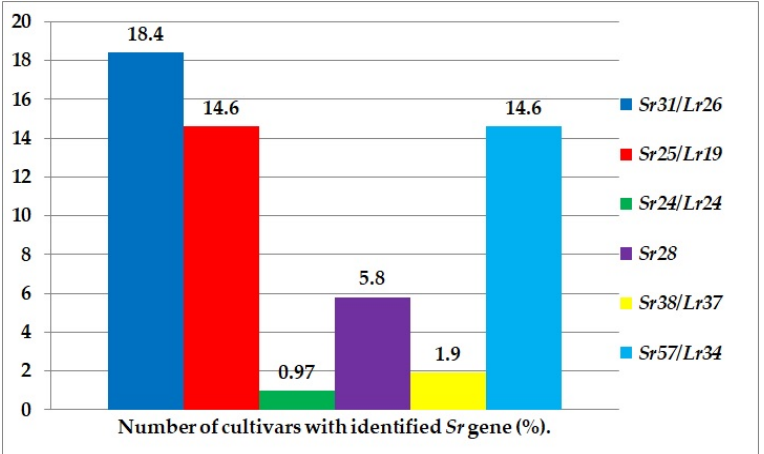
Figure 3. Representation of Sr genes in the studied wheat cultivars. Sr31 ( ’100 let TASSR’, ‘Balkysh’, ‘Chistopol’skaya’, ‘Ekada 253’, ‘Ekada 258’, ‘Ekada 265’, ‘Ershovskaya 36’, ‘Kur’er’, ‘Kvartet L 375’, ‘Prohorovka’, ‘Yugo-Vostochnaya 2’, ‘Yugo-Vostochnaya 4’, Antonina’, ‘Bezostaya 100’, ‘Bul- gun’, ‘Gurt’, ‘Svarog’, ‘Timiryazevka 150’, and ‘Vekha’); Sr25 (‘Aleksandrit’, ‘Dobrynya’, ‘Ekada 113’, ‘Hazine’, ‘Kinel’skaya 2010’, ‘Kinel’skaya niva’, ‘Kinel’skaya yubilejnaya’, ‘Kvartet L 375’, ‘L 503’, ‘L 505’, ‘Lebedushka’ ‘Tulaikovskaya 10’, ‘Tulaikovskaya 108’, ‘Tulaikovskaya nadezhda’, and ‘Ul’yanovskaya 105’); Sr24 (‘Ekada 265’); Sr28 (‘Chistopol’skaya’, ‘Kur’er’, ‘Margarita’, ‘Sakara’, ‘Yugo-Vostochnaya 4’, and ‘Vertikal’); Sr38/Lr37 (’Graf’ and ‘Svarog’); and Sr57/Lr34 (‘Bair’, ‘Bazis’, ‘Chernozemka 115’, ‘Hasyr’, ‘Liga 1’, ‘Malahit’, ‘Proton’, ‘Resurs’, ‘Skirda’, ‘Svetoch’, ‘V’yuga’, ‘Chistopol’skaya’, ‘Ekada 253’, ‘Kazanskaya Yubilejnaya’, and ‘Zhigulevskaya). Despite the fact that wheat cultivars with the Sr31 gene are affected by the Ug99 race and its biotypes, Sr31 remains the only gene present in Russian commercial cultivars that is effective against all Russian populations of the stem rust pathogen [4,27,28]. However, there were alarming reports about P. graminis f. sp. tritici isolates from the West Siberian stem rust population that were virulent against Sr31 [5]. As mentioned above, Sr31 is introgressed into the wheat from rye ( Secale cereale L.), localized in the 1BL.1RS translocation, and closely linked to genes for resistance to leaf ( Lr26 ) and yellow ( Yr9 ) rusts, as well as to powdery mildew ( Pm8 ). ‘Avrora’ and ‘Kavkaz’ cultivars, as carriers of 1BL.1RS, have long been used as parental forms in the development of wheat cultivars resistant to stem rust.